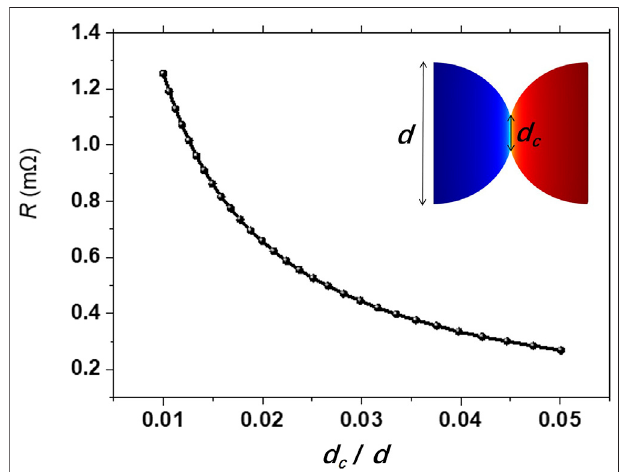
FIGURE1| Plotoftheinter-particle resistance R asafunctionof d c / d for a pair of touching spheres, where d c is the cross-sectional diameter of the overlap volumeand d thediameterofeithersphere.Theresultswereobtained from COMSOL simulations. As the ratio d c / d decreases, the inter- particle resistance R increases monotonously. In our resistor-network model, we assume the value of d c / d to be suf fi ciently small such that, while the value of R remains fi nite, any uncertainty in the value of D can be